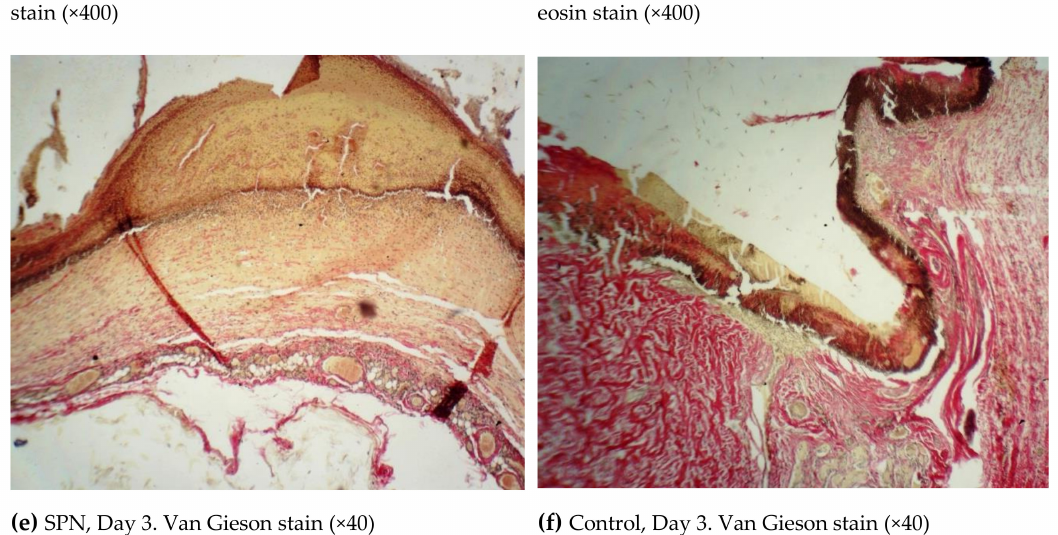
Figure 3. Morphological patterns of the SPN group wounds ( a , c , e ) and the control group wounds ( b , d , f ) on Day 3 of the